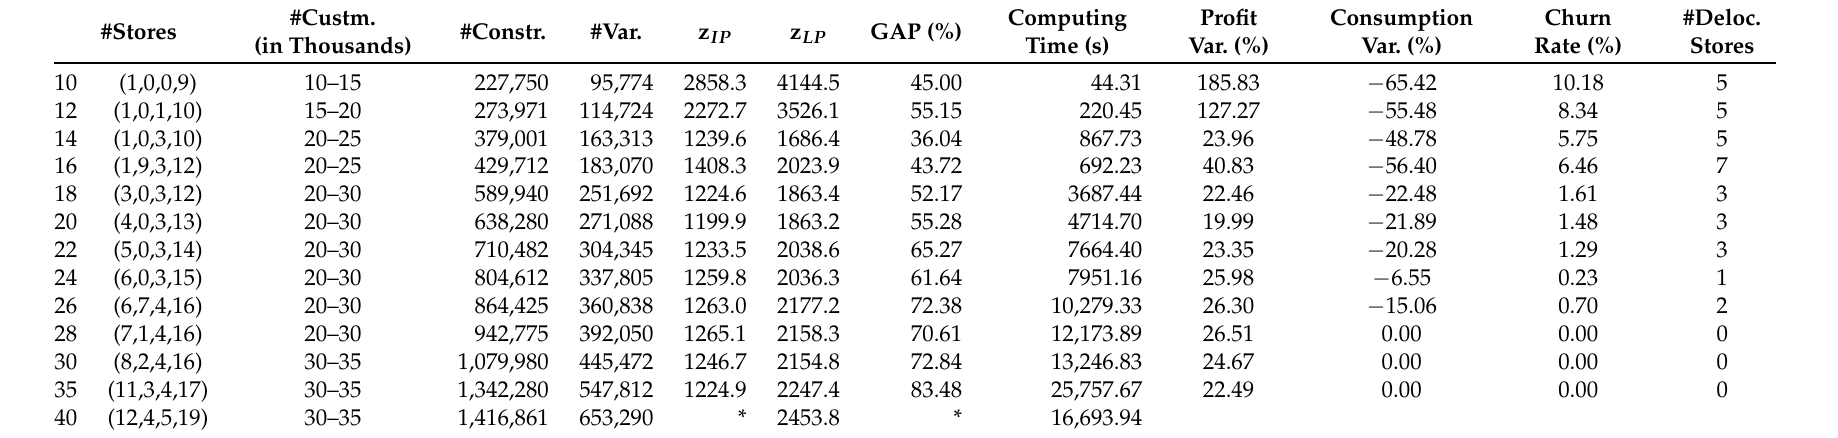
Table 4. Performance of the model for different